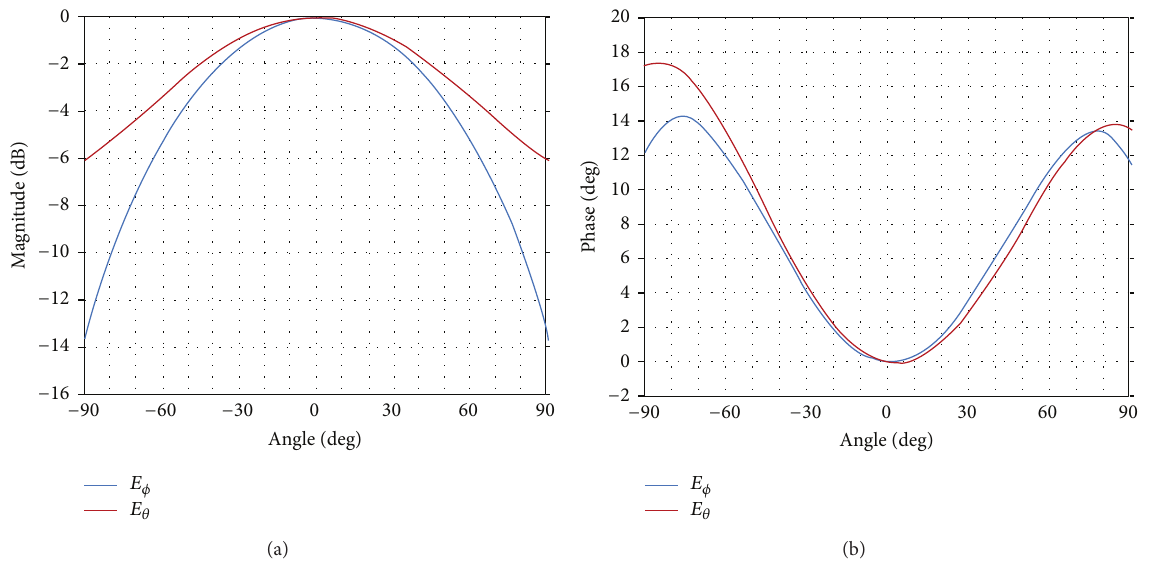
Figure 6: (a) Amplitude pattern of a circular waveguide at 𝑟 = 0.75𝜆 . (b) Phase pattern of a circular waveguide at 𝑟 = 0.75𝜆 .